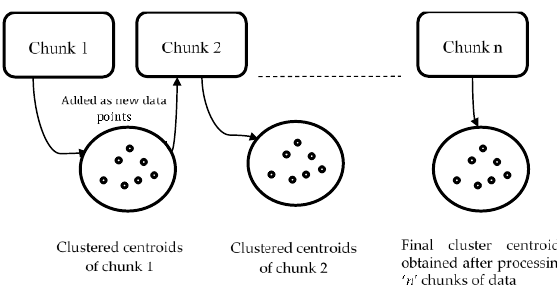
Figure 1. Single Pass clustering approach to IT2FCM-ACO.